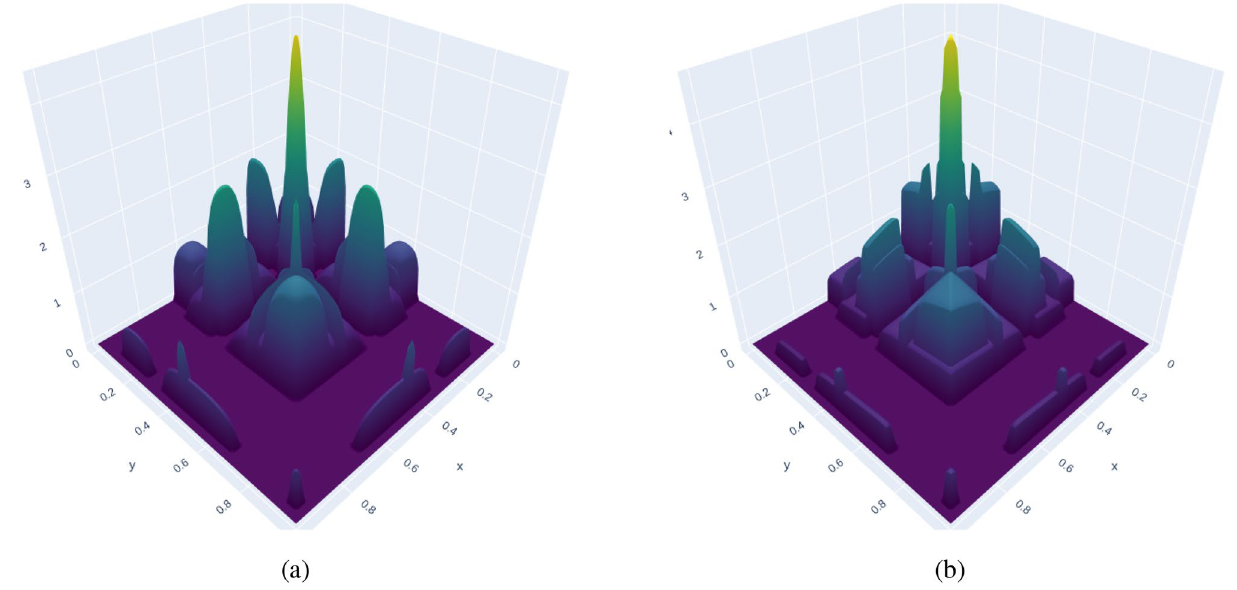
R R . The kernel uses a X × ⊂ ×